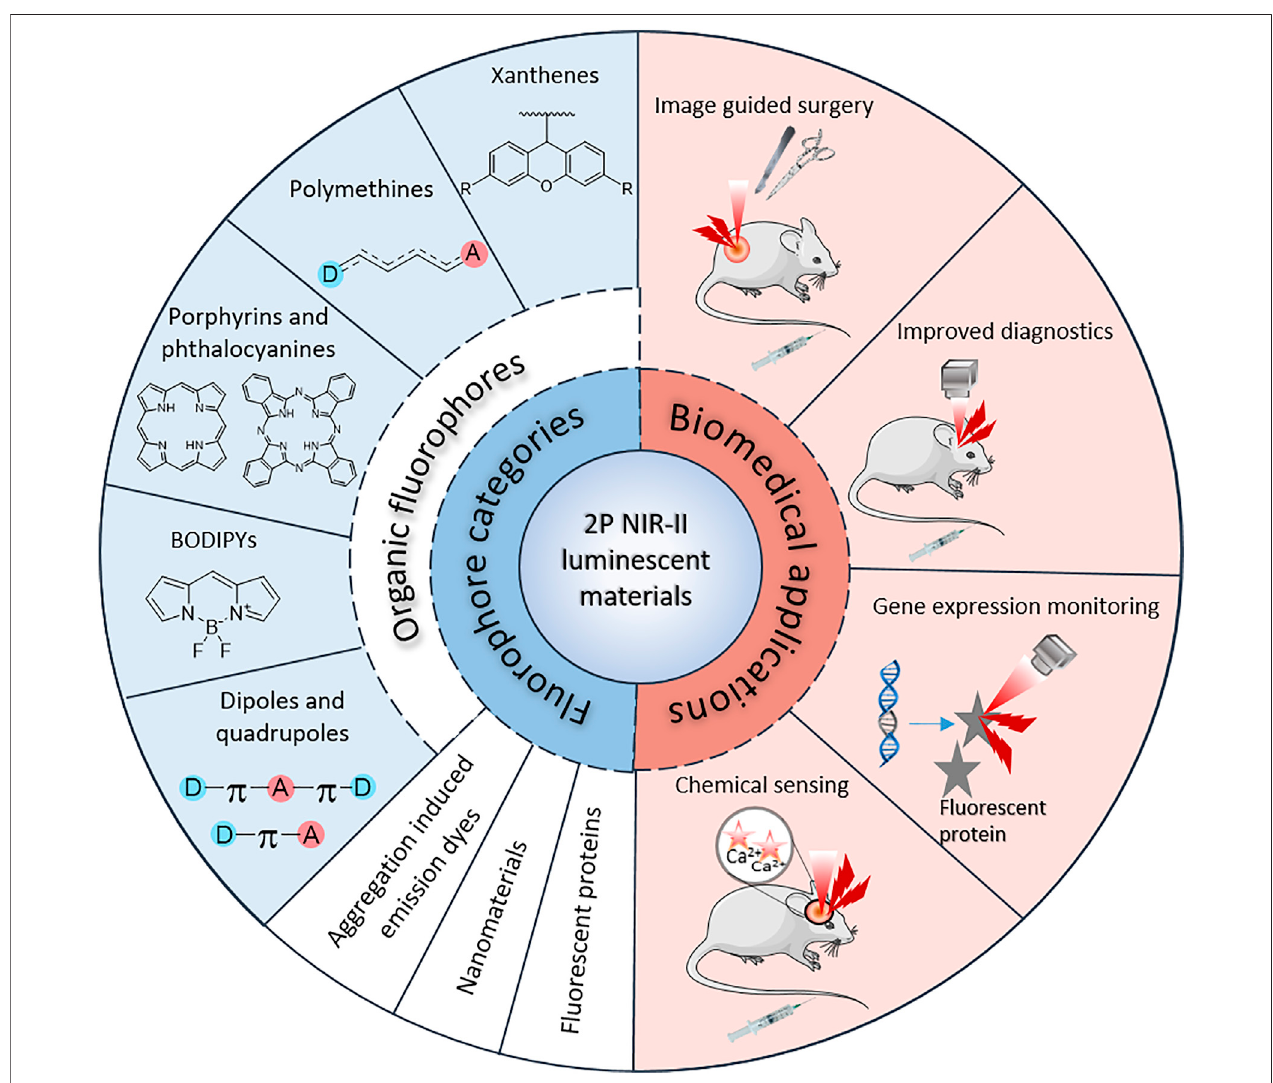
FIGURE 3 | Overview of fl uorophore categories and potential biomedical applications with 2PA NIR-II imaging.